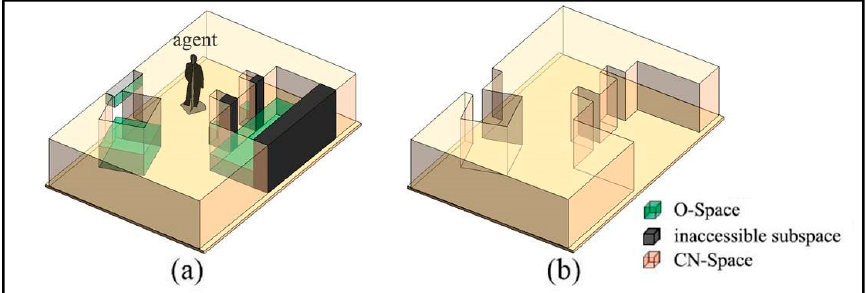
Figure 9. The CN-Space of Room A. ( a ) Inaccessible subspaces. ( b ) CN-Space.